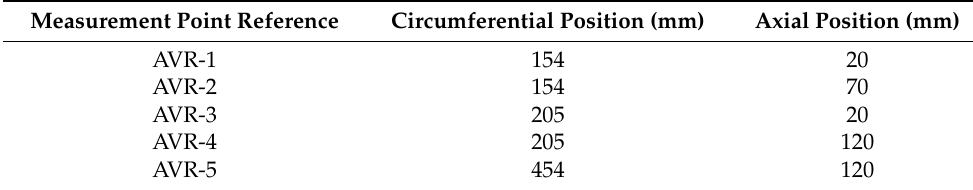
Table 4. Coordinates of acquisition points for AVR